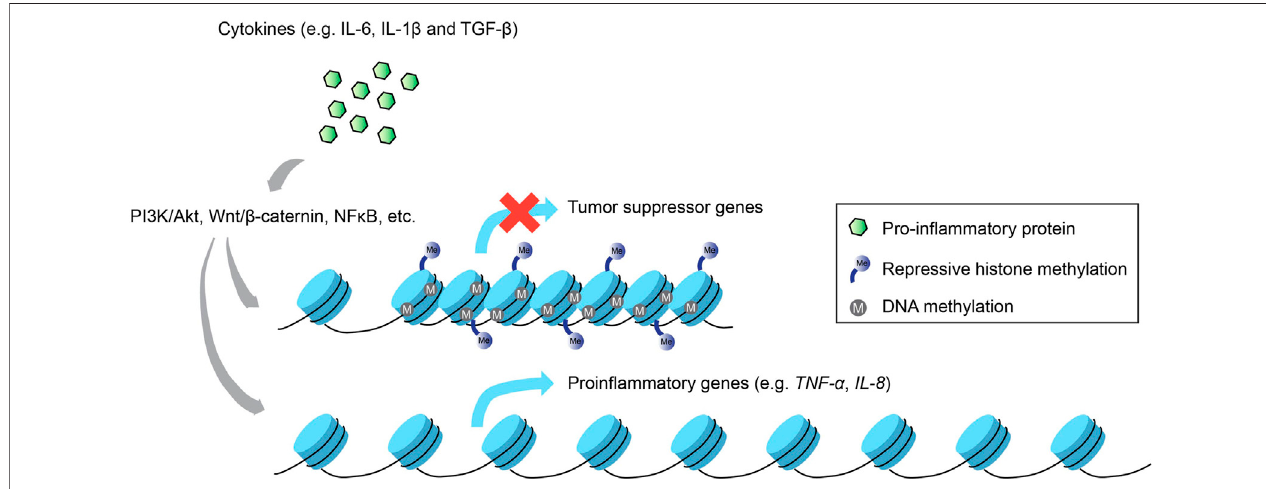
FIGURE 2 | In fl ammation-induced epigenetic alterations. Not only do epigenetic modi fi cations regulate in fl ammatory gene expression, the activation of in fl ammatory signaling pathways via proin fl ammatory cytokines can also enact changes to the epigenetic landscape that result in the silencing of tumor suppressor genes and the increased activation of proin fl ammatory genes that promote